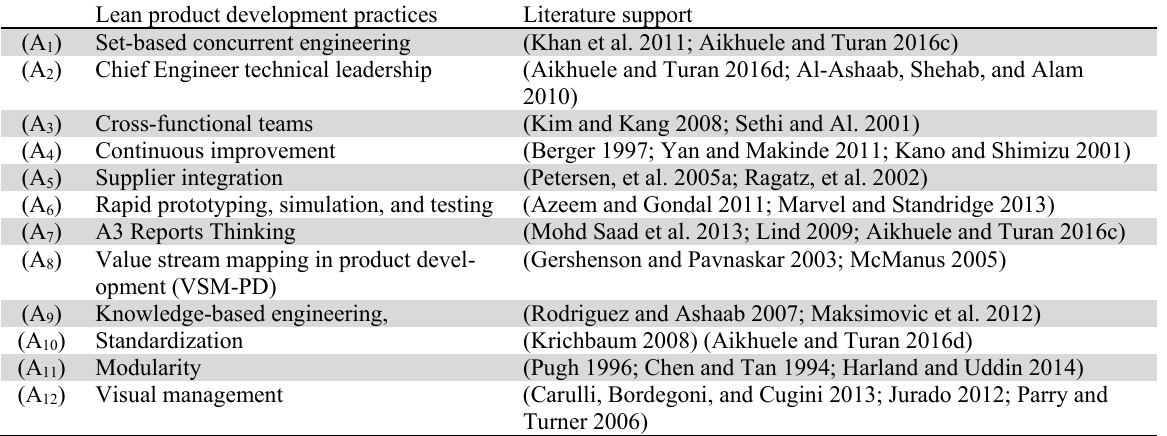
Extended lean product development